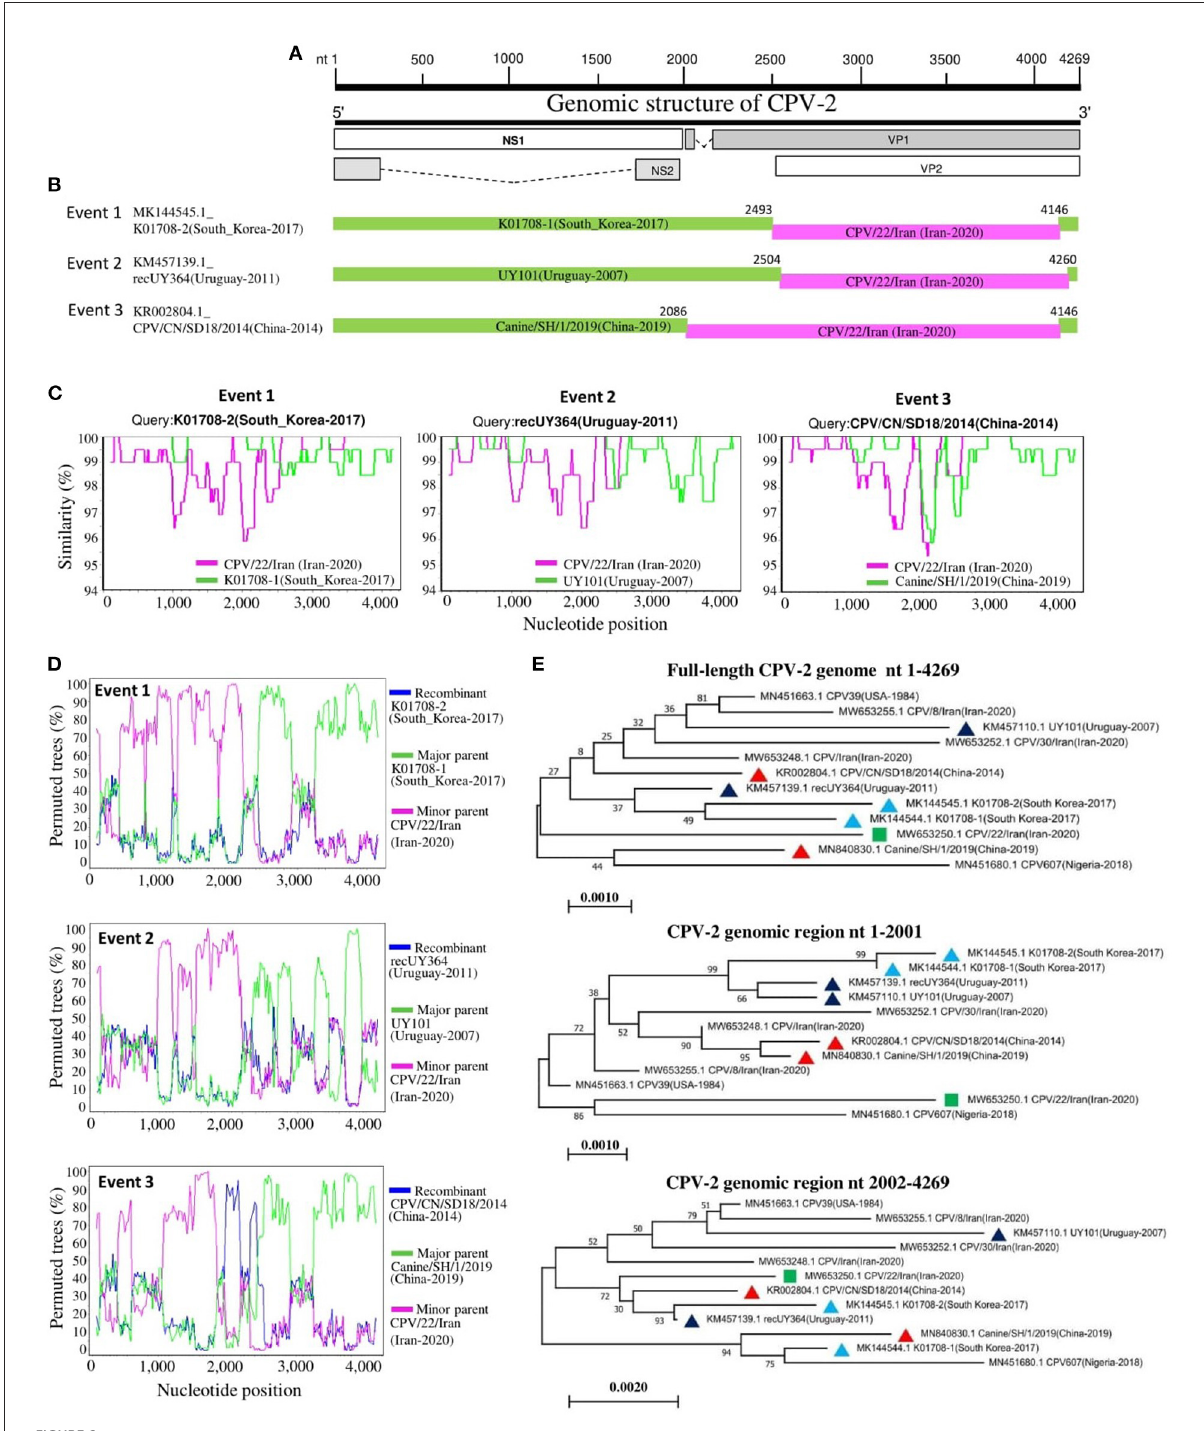
FIGURE6 Recombination analysis of circulating CPV-2 genomes. (A) A schematic of the genome organization of CPV-2 is shown at the top of the figure. (B) Diagram of the genomes of recombinant viruses. The major parents are in green, while the minor parents are in pink. The numbers indicate the nucleotide positions (nt) of beginning and ending breakpoints of recombination and are relative to the genomic sequence of corresponding recombinant viruses. (C) Genomic similarity Simplot analysis of viruses involved in the three recombination events. (D) Bootscanning analysis of viruses involved in the three recombination events with the genome of CPV607 (GenBank ID: MN451680.1) as a non-recombinant reference. (E) Phylogenetic analysis of seven viruses involved in recombination events and five non-recombinant viral strains based on the full-length genome or the indicated genomic regions. The virus is indicated in the format of GenBank ID_virus name (collection country-collection date). The minor parent is indicated with a green square. The viruses detected in South Korea, Uruguay, and China are labeled with blue, black, or red triangles, respectively. The numbers at each branch indicate the bootstrap values (%) of 1,000 replicates. The scale bars indicate the number of inferred substitutions per